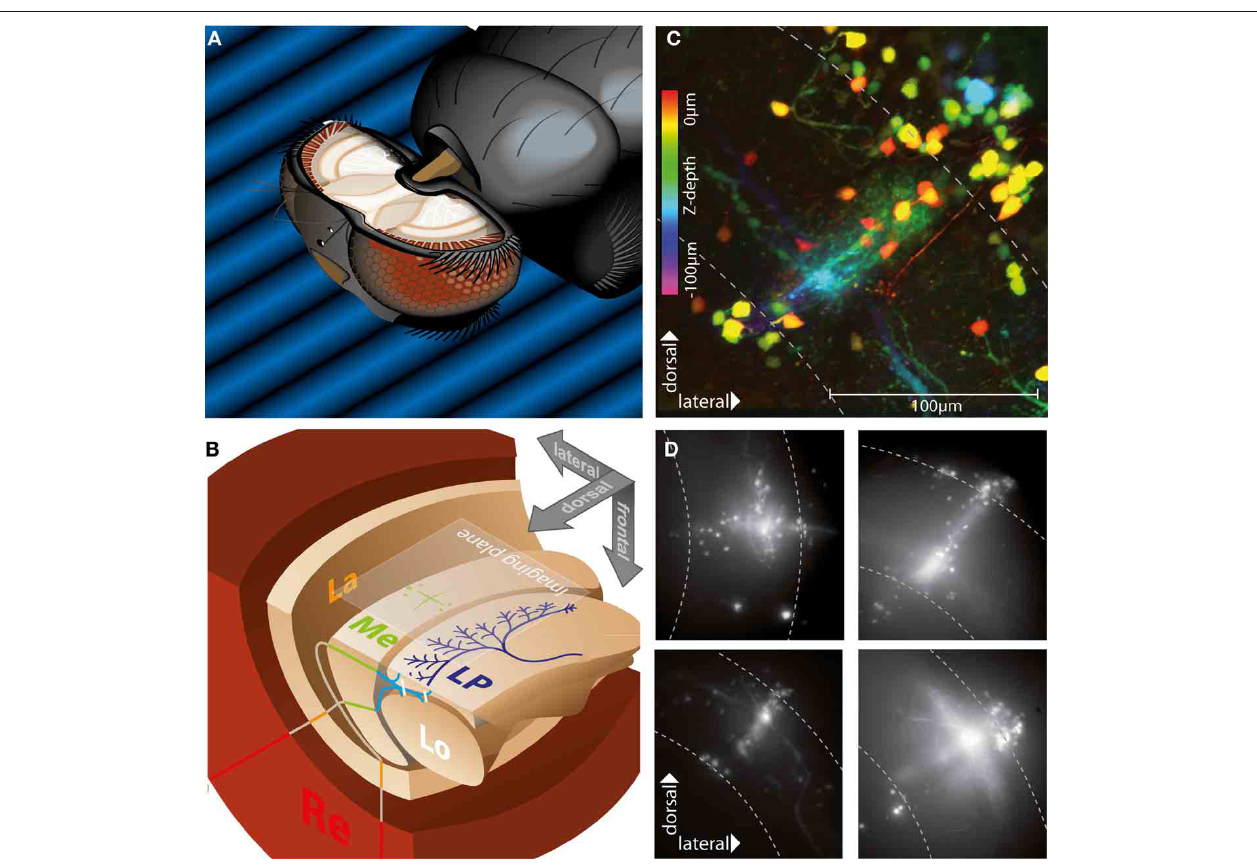
between lamina and medulla and at the second chiasm between medulla, lobula and lobula plate. The imaging plane of the camera is aligned with the caudal surface of the brain, so that dorsal is on top. (C) Collapsed confocal image stack of an exemplary Calcium Green dextran population staining in the medulla, showing a columnar bundle of axons, perpendicular tangential dendrites, and two groups of somas located superficially near the proximal and distal boundaries of the medulla. Color coding of the structures indicates depth. Medulla boundaries are indicated by the dashed lines. (D) Collapsed image stacks obtained with widefield microscopy of four examples of population staining in different parts of the medulla. Stainings usually show two groups of somas and tangential as well as columnar structures, with the crossing point corresponding to the injection site in different layers of the